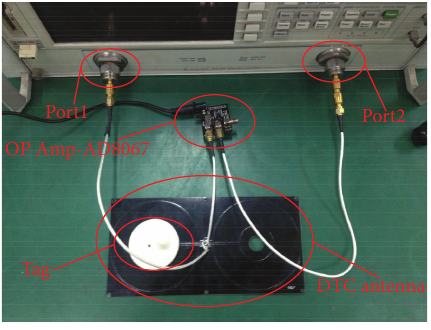
Figure 7: The complete testing circuit of the DTC antenna.